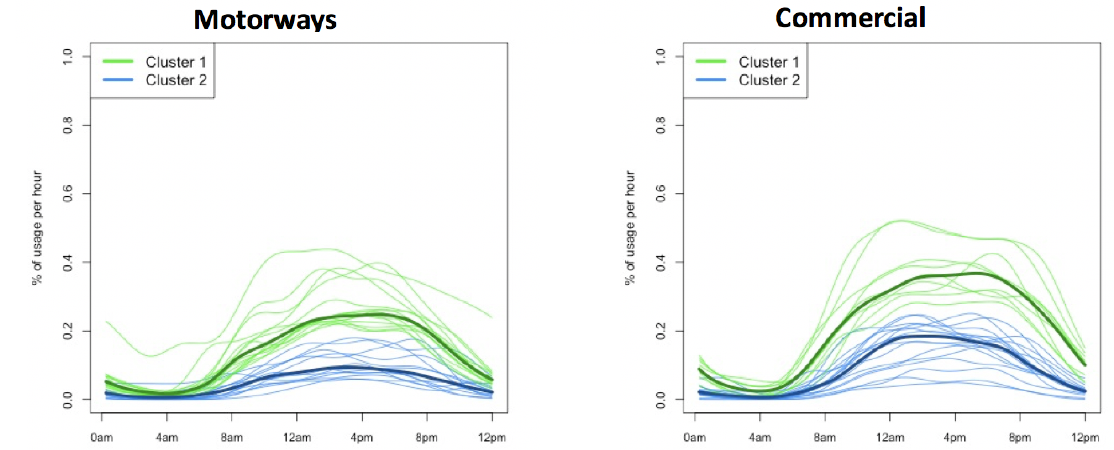
Figure 15. Clustering results for Fast-Commercial and Fast-Motorway subgroups.